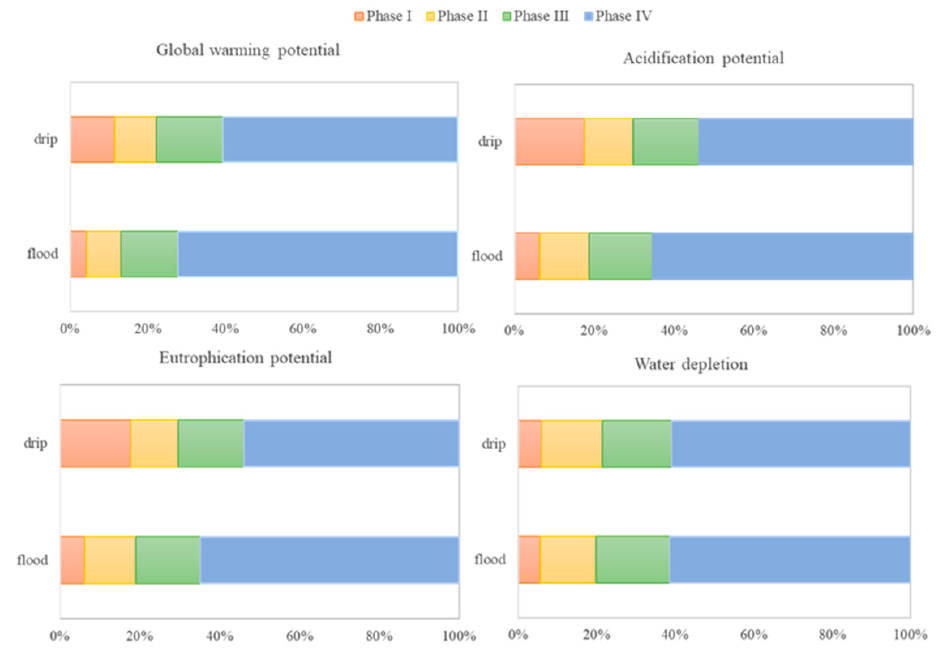
Figure 5. Phase contribution analysis of the furrow and drip irrigated pear production system. Phase I–IV represent the orchard installation phase, the primary growing phase, the low production phase, and the full production phase, respectively.